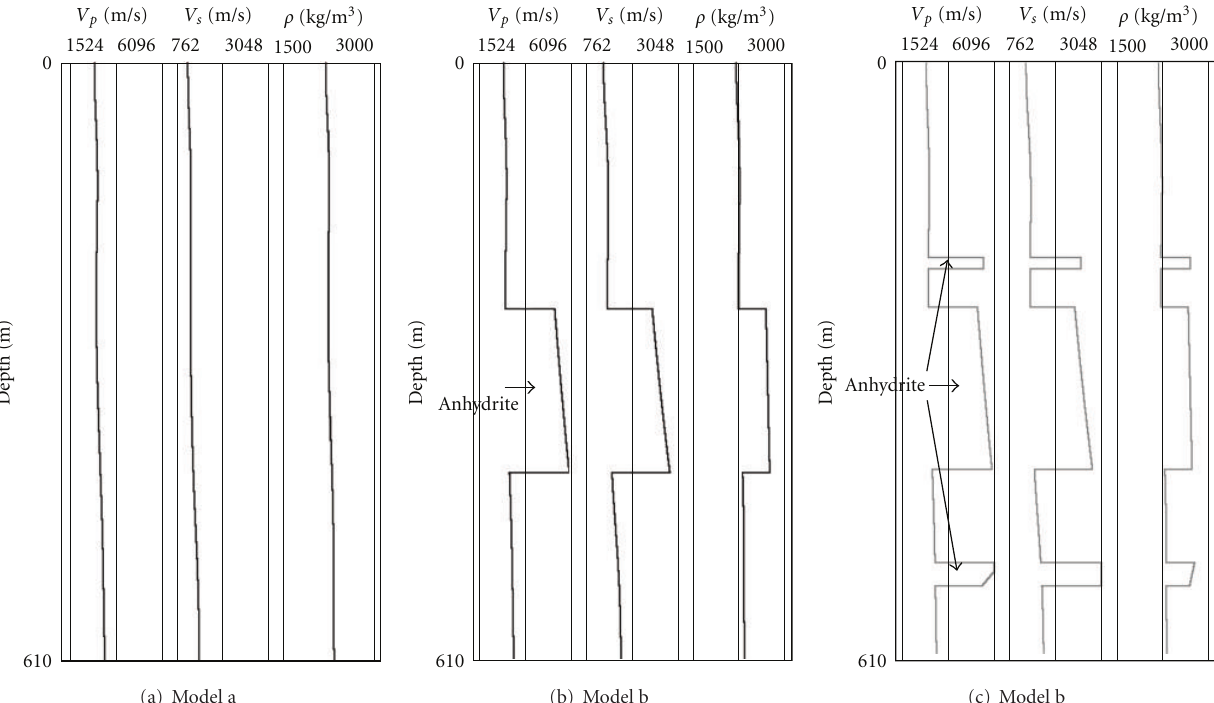
Figure 6: The three di ff erent versions of the 1D models shown in Figure 5, used to understand the e ff ect of shallow anhydrite layers. Model a—no anhydrite layer, Model b—one anhydrite layer, and Model c—three anhydrite